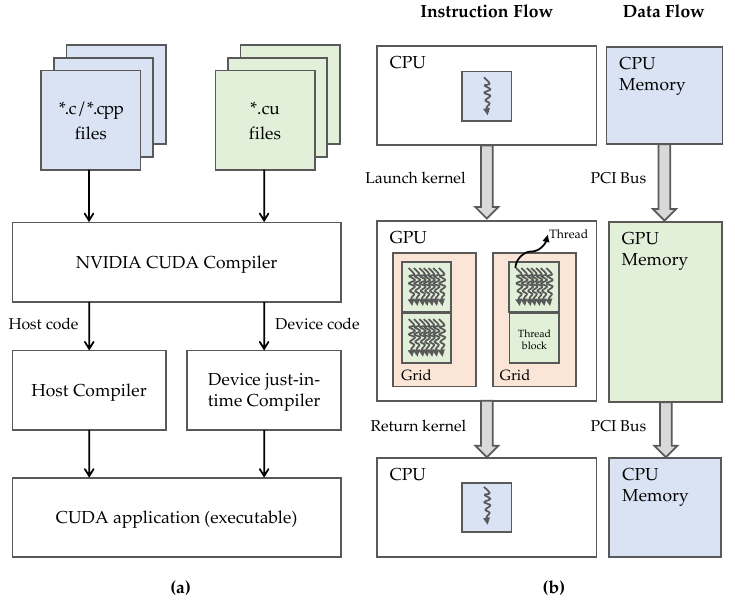
Figure 1. ( a ) Compilation process of CUDA C/C++ sources; ( b ) CUDA instructions and data flow at runtime.